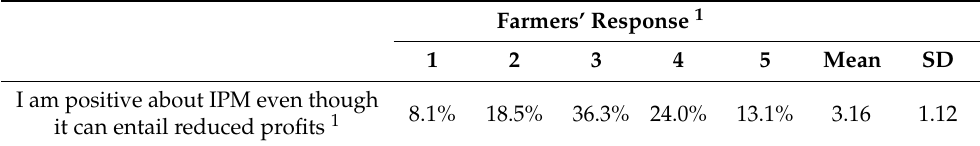
Table 4. Respondent attitudes to IPM if it implies reduced profits (N = 617,